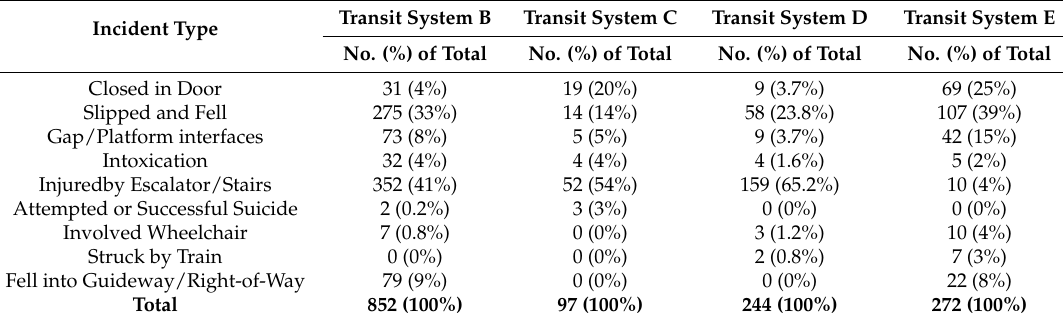
Table 3. Number and aggregate percentages for transit systems B, C, D, and